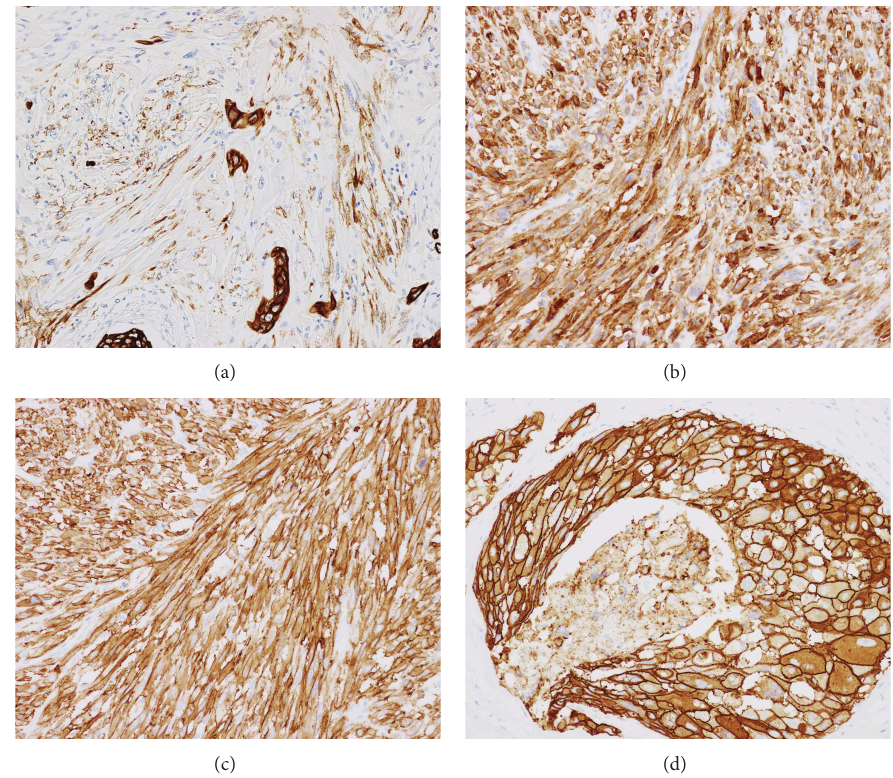
Figure 4: Immunohistochemical staining of the right breast carcinoma. (a) Spindle-shaped tumor cells were focally and weakly positive for cytokeratin CAM5.2, but diffusely and strongly positive for (b) CD10 and (c) HER2 oncoprotein. (d) Apocrine carcinomas strongly expressed HER2 in their cell membrane.